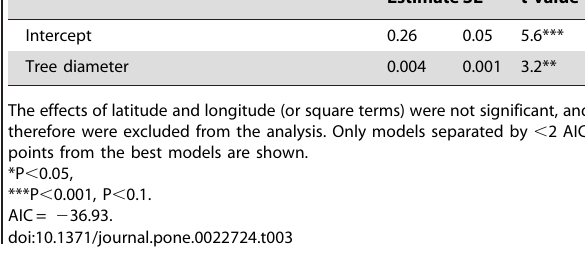
vocalization (Figures 2, 4). The latter spectral parameter was also associated with overall species richness in Capercaillie plots (GLM: b 6 SE = 2 22 6 9, t 10 = 2.7; P =0.020), suggesting that males singing the lower pitched songs settled in stations and plots where bird diversity was highest. Male singing at low frequencies displayed in arenas where the cover of tall shrubs was high (GLM t 10 = 5.3; P =0.0007).